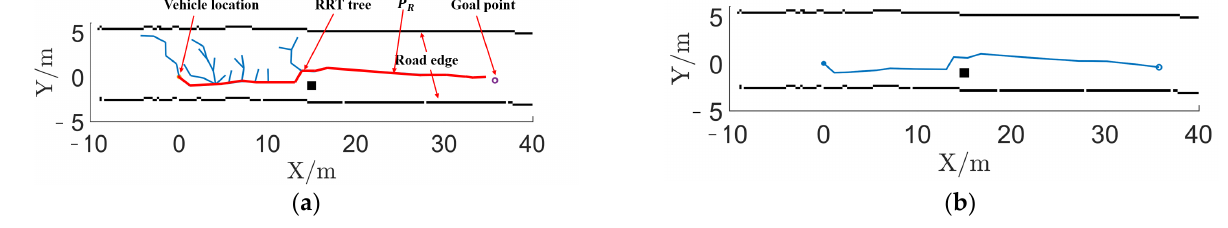
Figure 5. An example of Γ : ( a ) RRT-Tree; ( b ) P R .